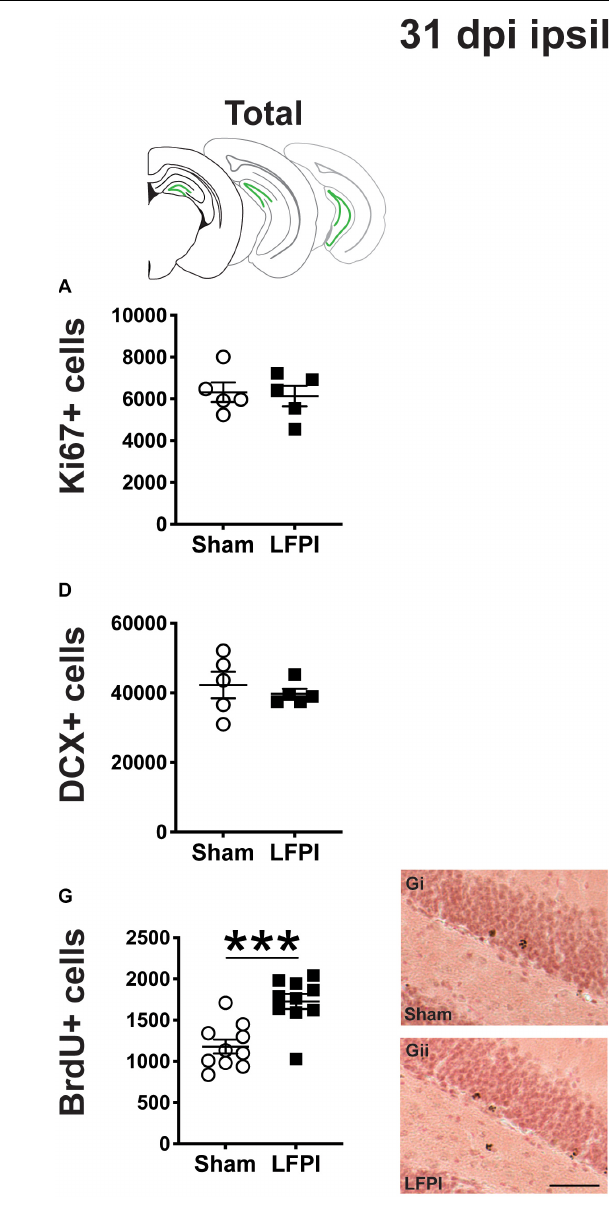
( Figure 2G ). Parcellation of Sham and LFPI BrdU + SGZ cell counts into anterior and posterior DG bins also showed no effect of injury ( Figures 2H,I ). While both Ki67 and short-term BrdU were examined as indices of proliferation in the SGZ, they do not represent the same cell population; exogenous BrdU “pulse” labels cells in S-phase, while Ki67 is an endogenous marker of cells in G1, S, G2, and M phase. Thus, despite the lack